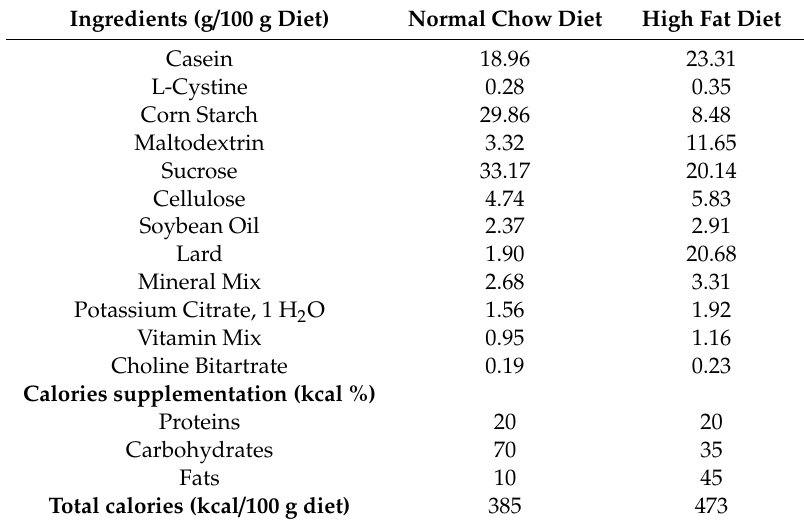
Table 1. Compositions of experimental